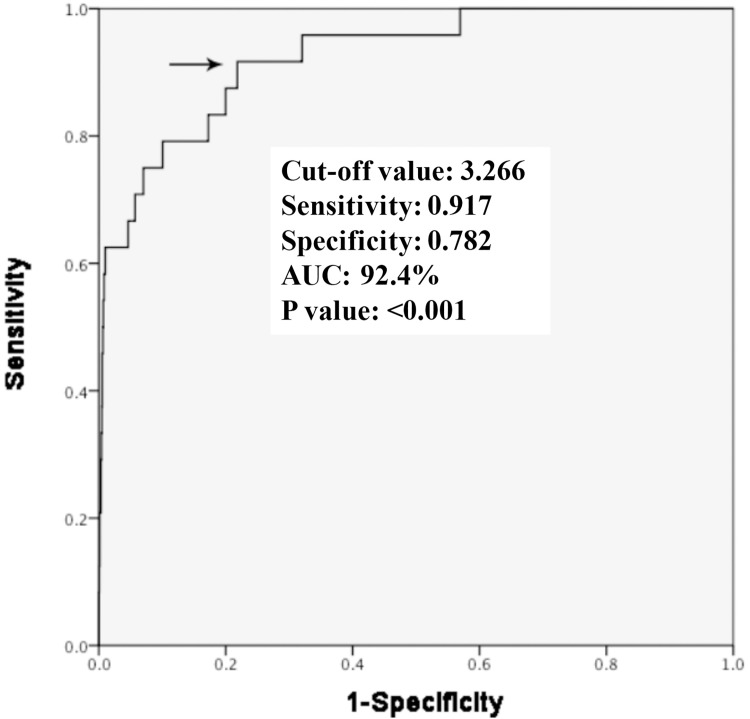
Receiver Operating Characteristic (ROC) curve demonstrates the optimal threshold and goodness of fit for the SAFE-T map for the prediction of focal VT origin.